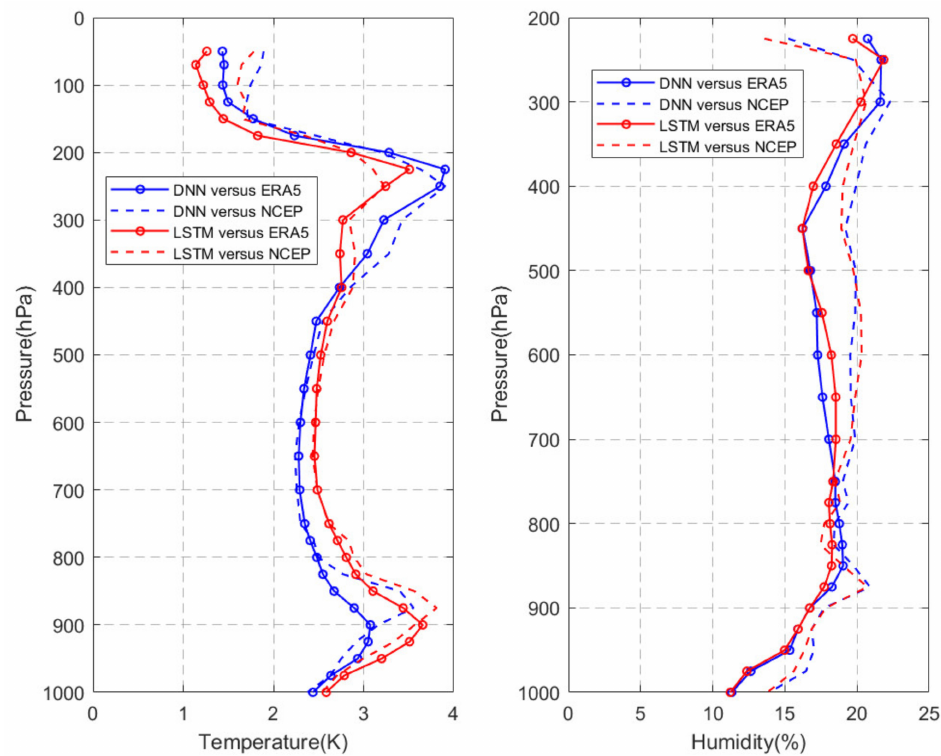
Figure 13. The retrieval RMSEs of the DNN and LSTM models compared with ERA5 over mixed surface in June 2021.